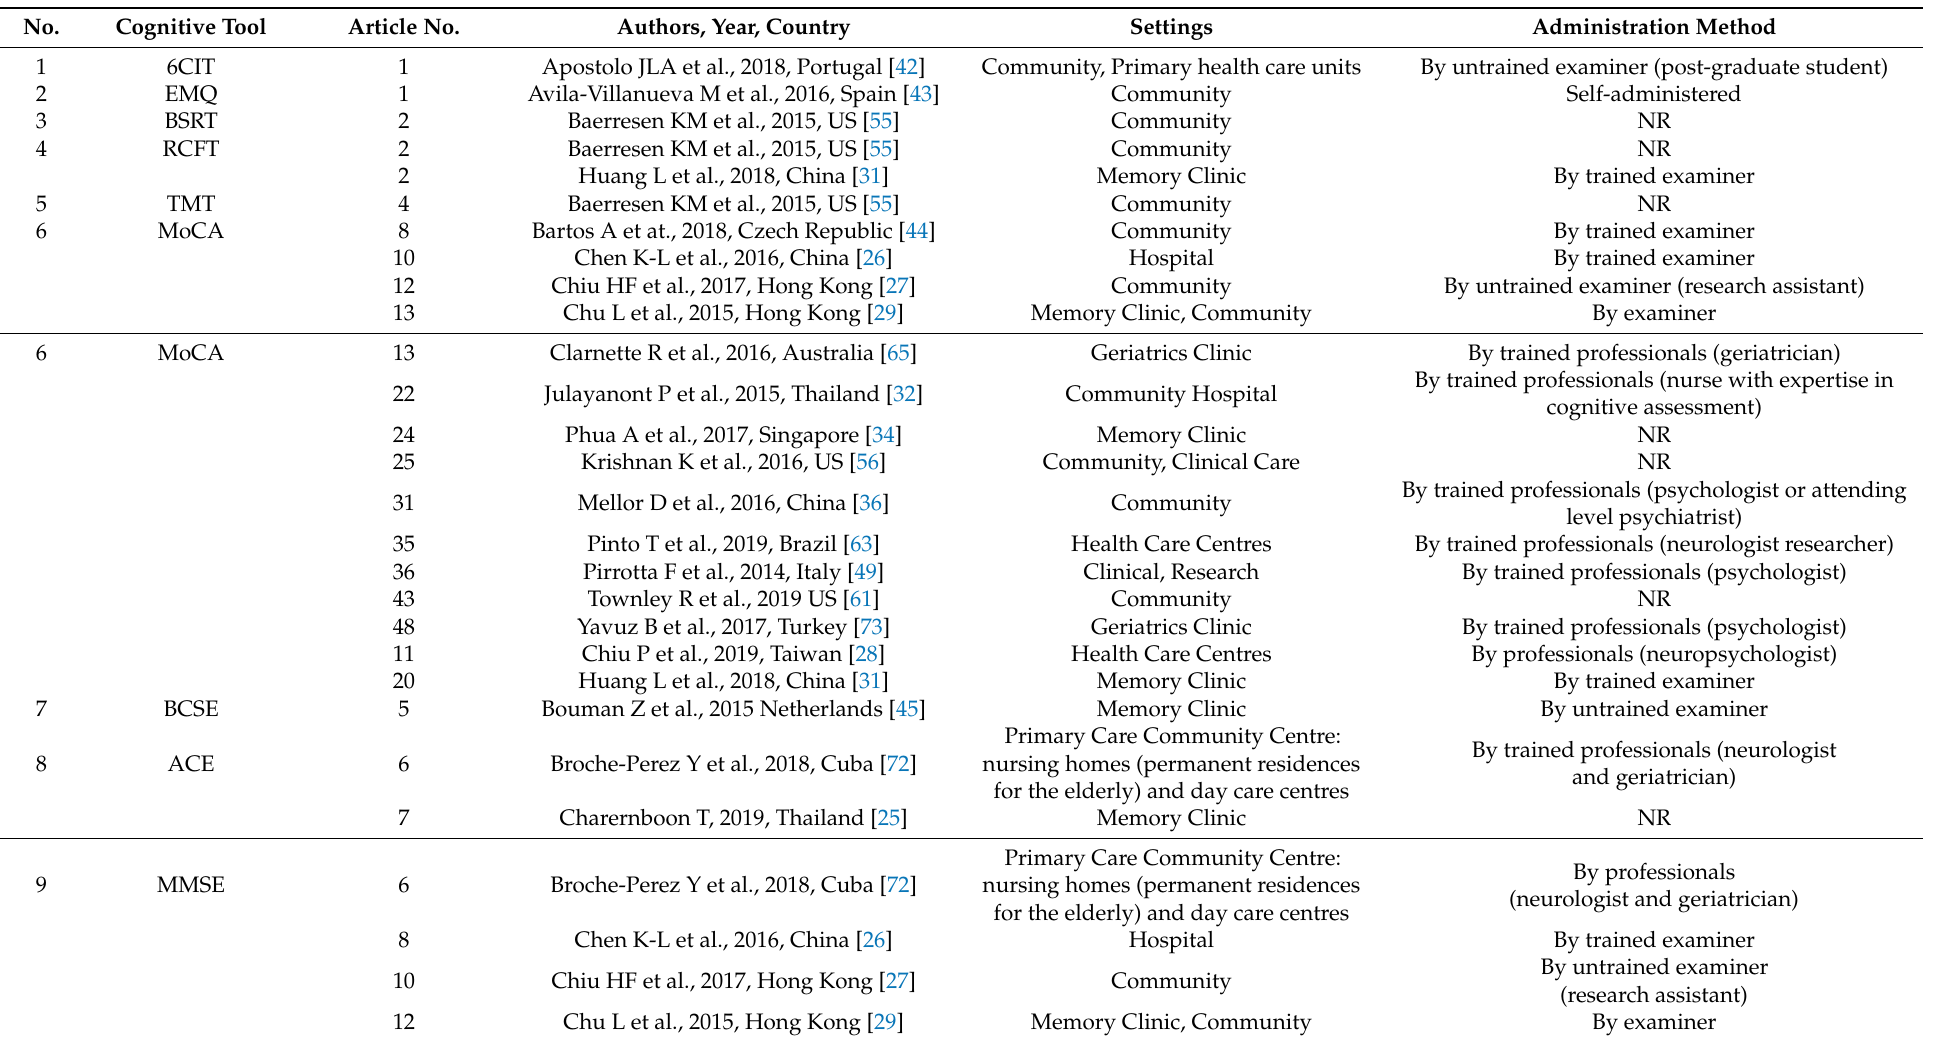
Table 3. Included Tools and Its Study